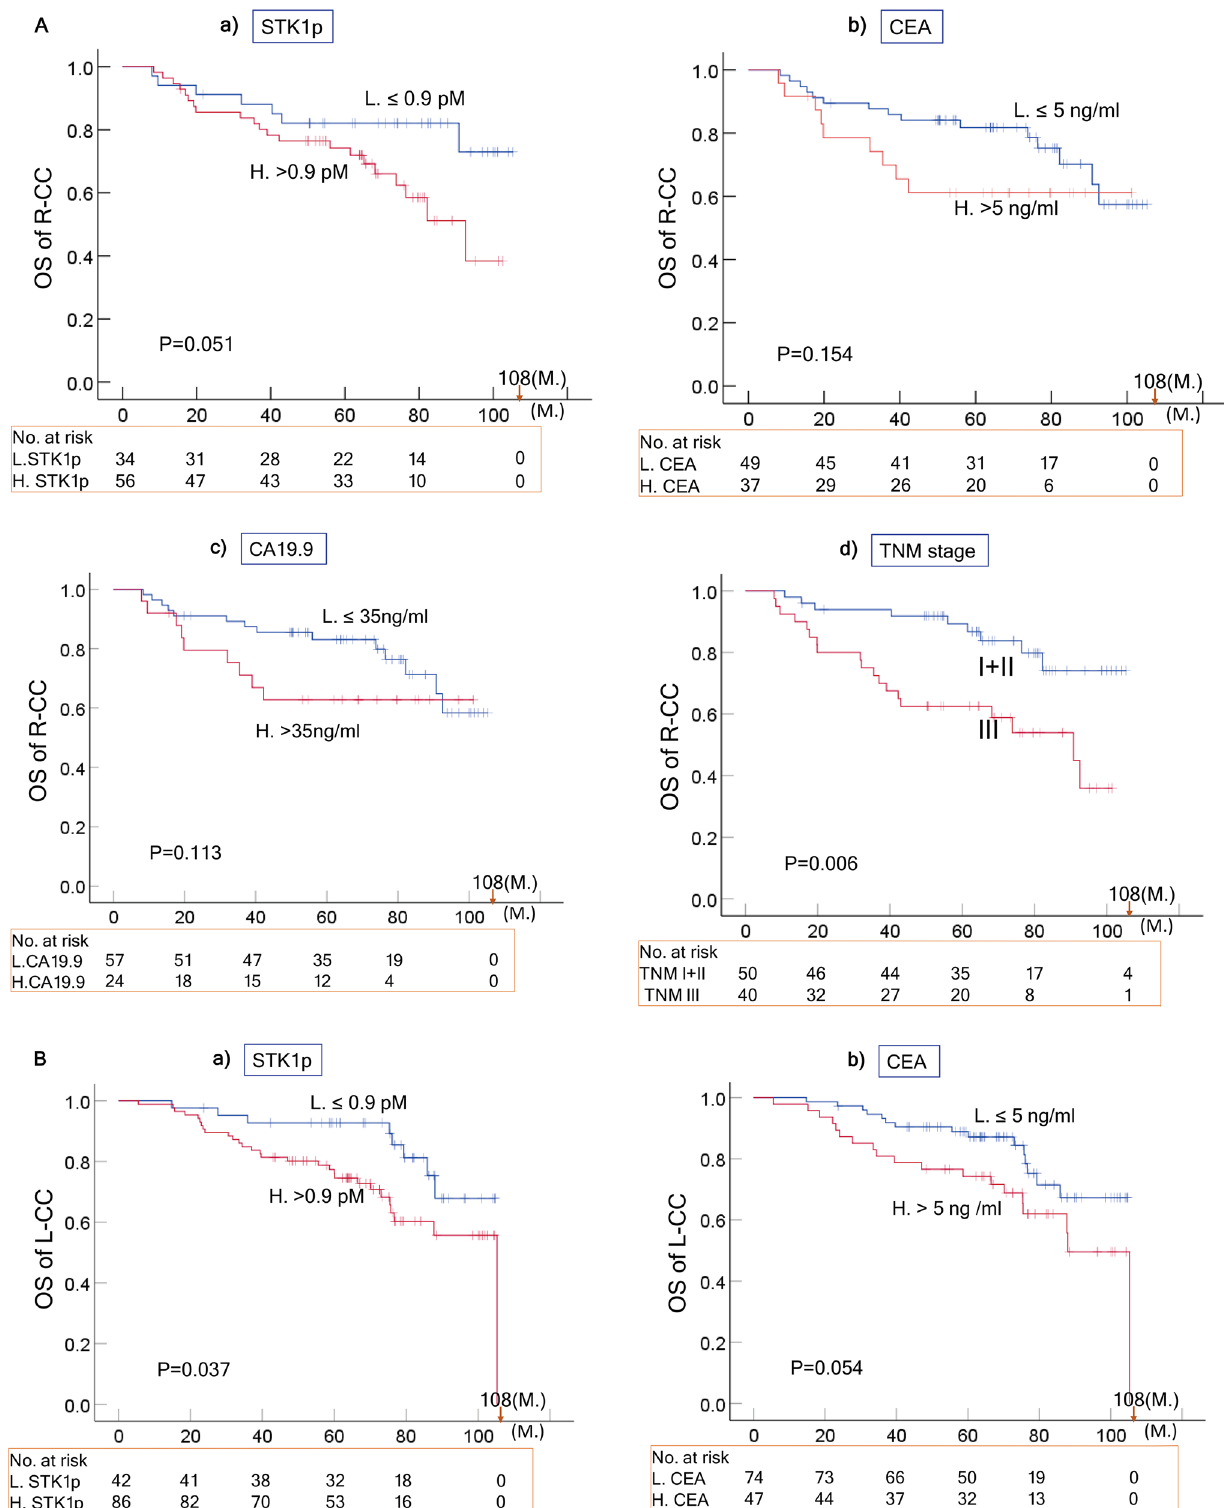
Fig. 3 Overall survival (OS) curves of R-CC ( A ), L-CC ( B ) and RC ( C ) related to STK1p, CEA, CA19.9, and TNM stage based on the Kaplan–Meier plotter database. The solid dots in the survival curves show the times of censored observations. M: